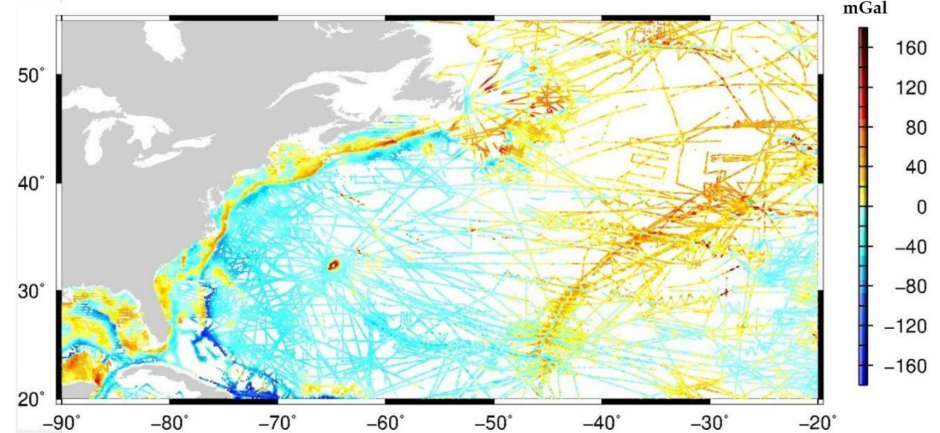
Figure 2. Geographic distribution and values of marine gravity